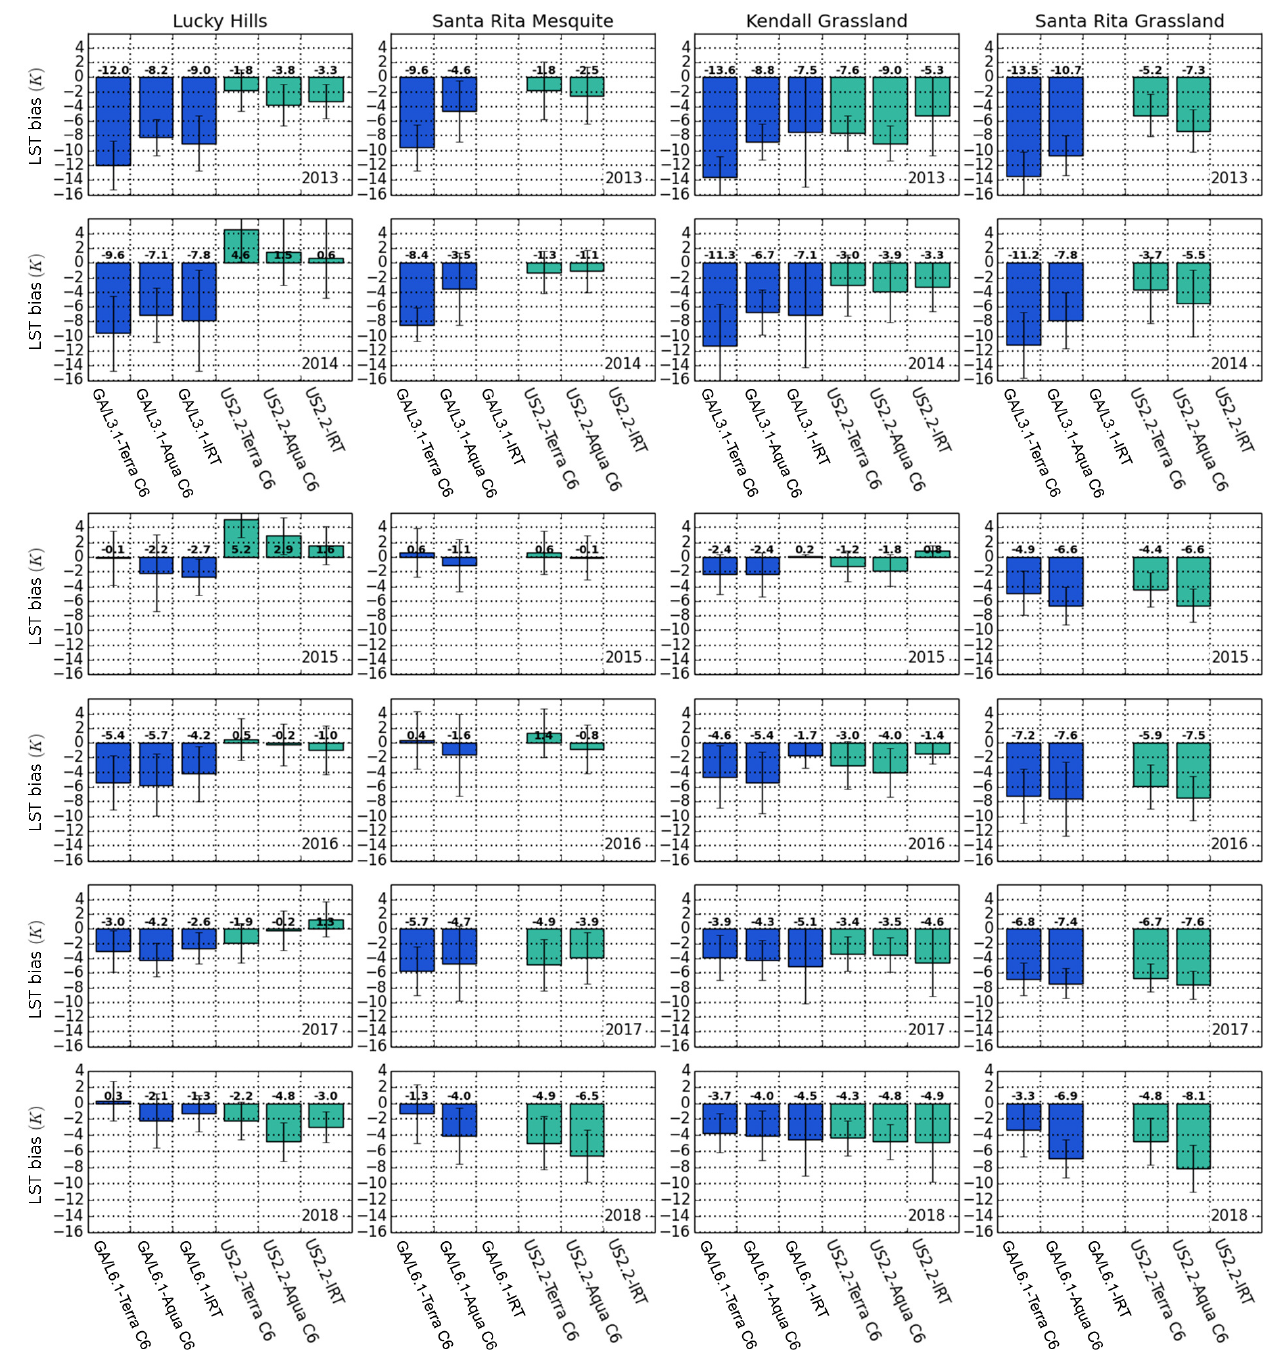
Figure 3. Daytime LST biases from the online UM configurations compared with MODIS C6 Terra and Aqua LST retrievals at the four eddy-covariance flux sites: Lucky Hills, Santa Rita Mesquite, Kendall Grassland and Santa Rita Grassland. The GA/L3.1 configurations (2013, 2014), the GA/L6.1 configurations (GA/L6.1_17km_static: 2015; GA/L6.1_17km_VarBC: 2016, 2017; and GA/L6.1_10km_VarBC: 2018) are shown in blue. The US2.2 configuration is shown in cyan. The LST evaluation was performed for 6 years: 2013 (row 1), 2014 (row 2), 2015 (row 3), 2016 (row 4), 2017 (row 5) and 2018 (row